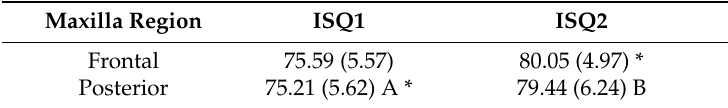
Table 4. Tukey’s multiple comparison test of ISQ1 and ISQ2 values for different maxilla regions (frontal and posterior). Numbers are means and values in brackets are standard deviations. Uppercase letters indicate statistically significant differences between the ISQ 1 or 2 values within the maxillary region. * indicates statistically significant differences between ISQ 1 and 2 values across the maxillary